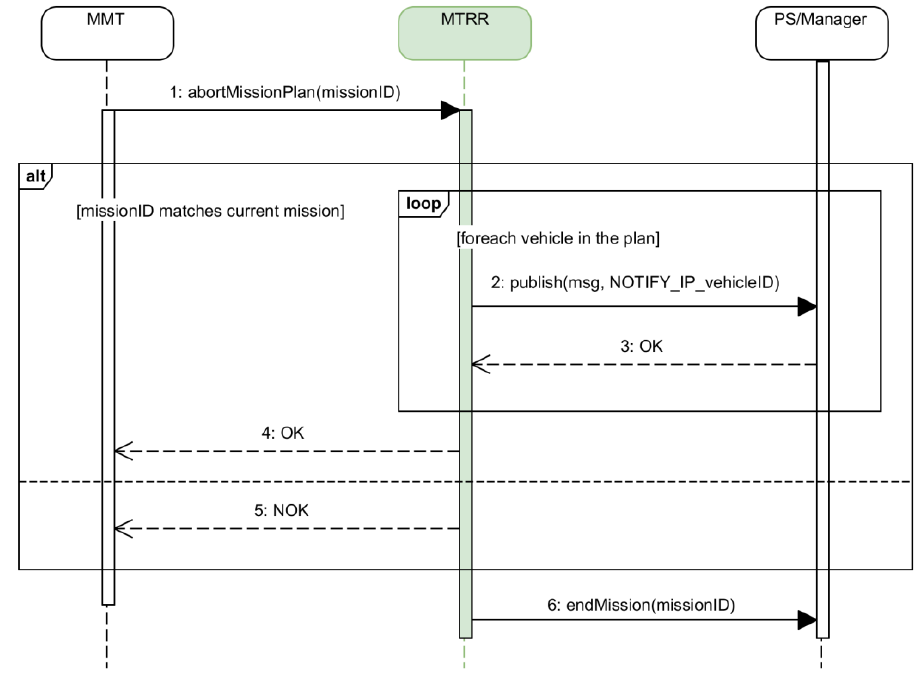
Figure 22. Sequence diagram for aborting the full mission.